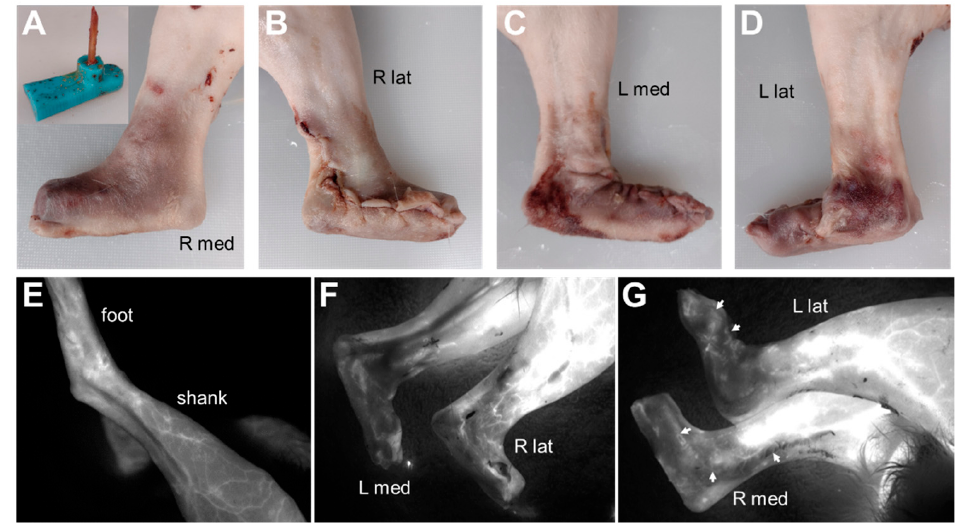
Figure 2. Fluorescence imaging in rabbit N2 to visualize blood flow in skin flap covering a mock foot–ankle prosthesis ( A , inset ). ( A , B ) Right hindlimb with lateral longitudinal incision. ( C , D ) Left hindlimb with cranial longitudinal incision. ( E ) Fluorescence imaging of left hindlimb before inci- sions. ( F,G ) Fluorescence imaging of hindlimbs after skin flaps were sutured closed over the mock prostheses. Blood flow in the skin flap was diminished compared to the pre-incision foot but still visible throughout the skin flap, including along the incision lines ( G , arrows ). Qualitatively, blood flow appeared better in the right hindlimb with the lateral longitudinal incision than in the left hindlimb with the cranial longitudinal incision.